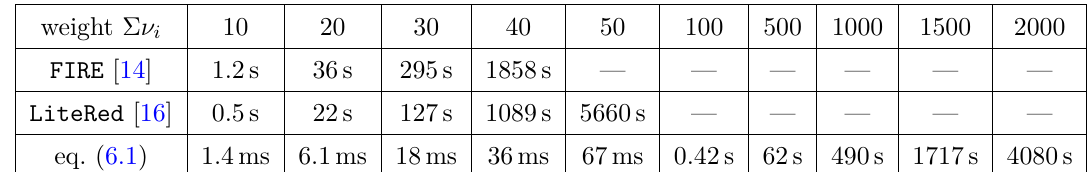
Table 1 . Runtime comparison of different strategies to reduce the integral B ν 1 ,ν 2 ,ν 3 its three master integrals. In each case, we have averaged over 10 randomly chosen positive index triples of fixed weight Σ ν i . Concretely, running Mathematica 13.0 on a 1.5 GHz AMD Epyc 7452 processor we compare a naive implementation of eq. (6.1) with reductions generated by FIRE version 6.4.2 and LiteRed version 1.83. Dashes stand for runtimes exceeding a timeout that we had set to be 2